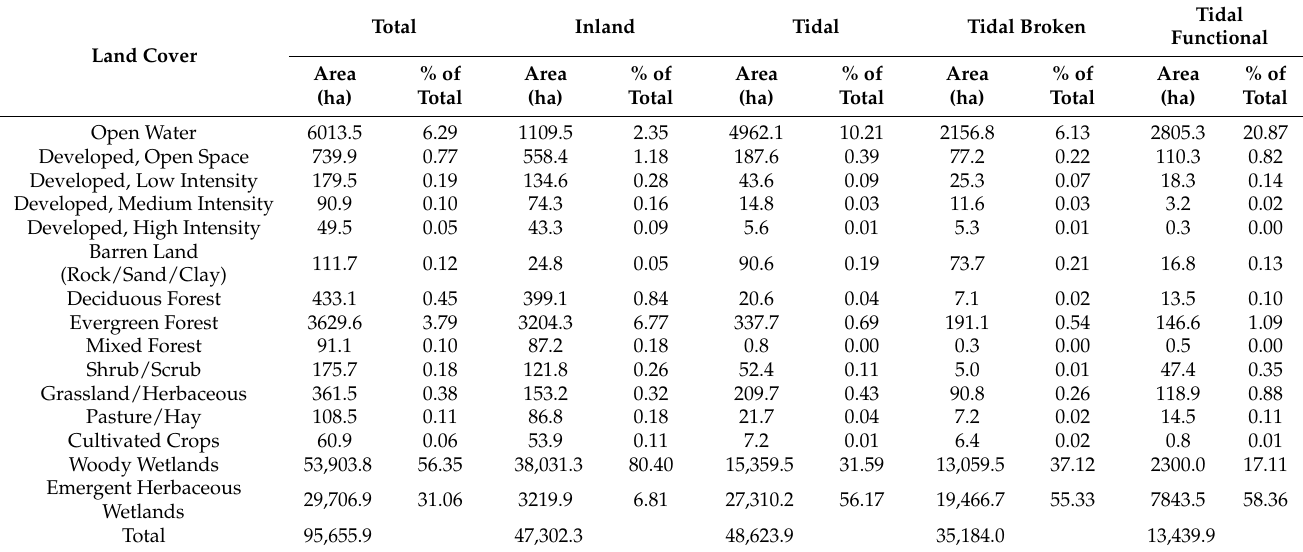
Table 1. Distribution of historic rice fields within the various National Land Cover Data (NLCD) categories for the total area, as well as for both inland and tidal fields.